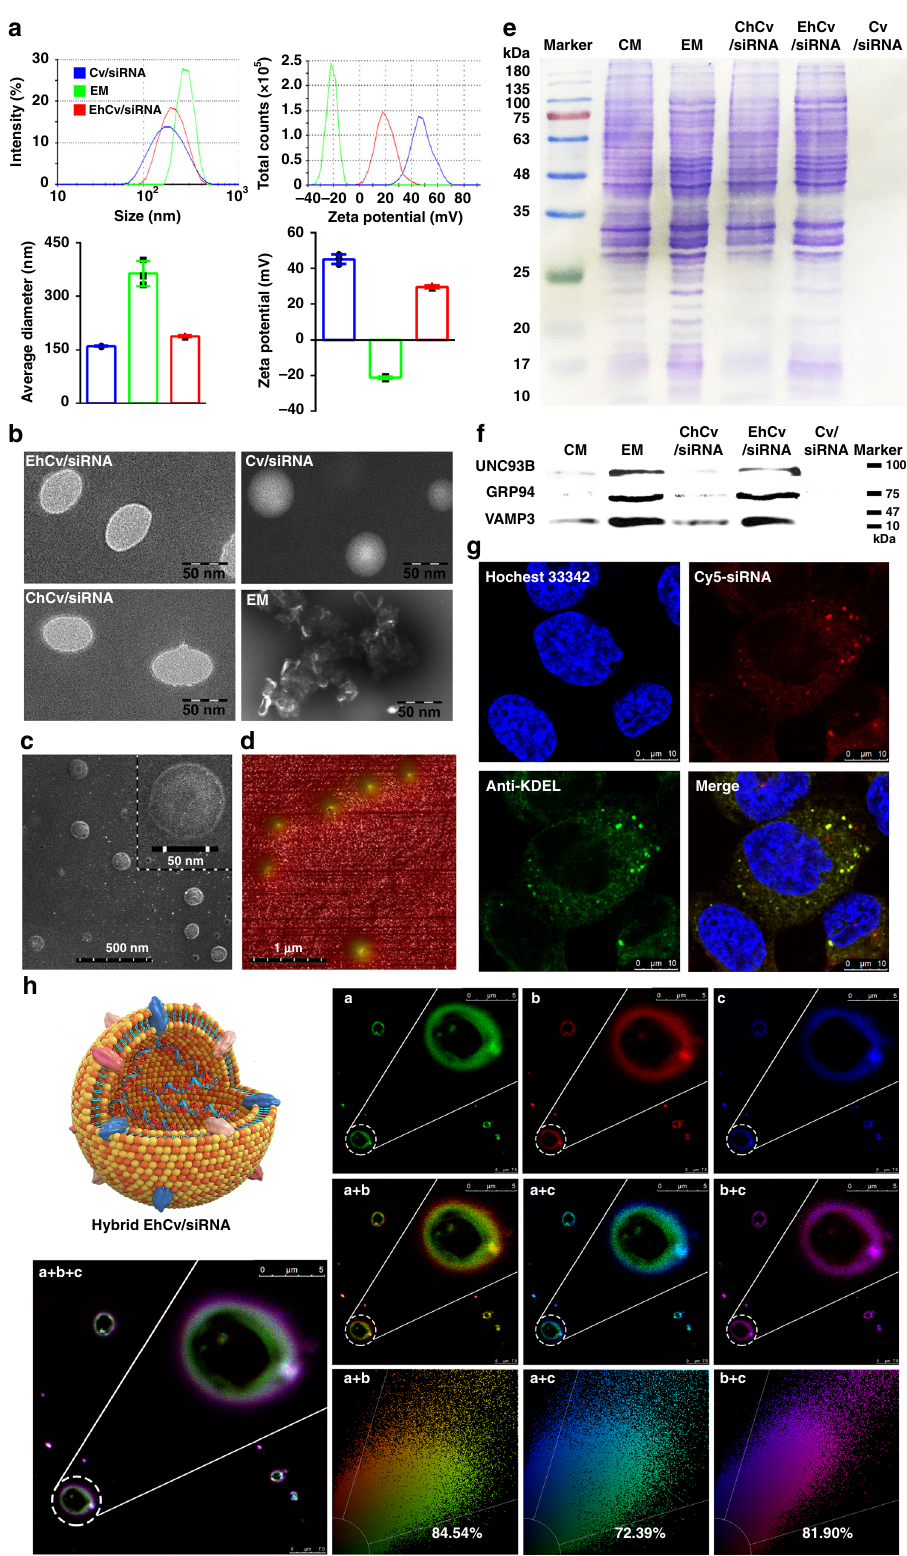
cellular uptake ability of EhCv/siEGFR NPs in three different types of cells. Similarly, the EhCv/siEGFR NPs with a decoration of EM isolated from HT-1080 cells also exhibited a relative higher cell uptake with no cell type selectivity (Fig. 3f). The fact that the decoration of EM improving cell uptake of EhCv/siEGFR NPs in